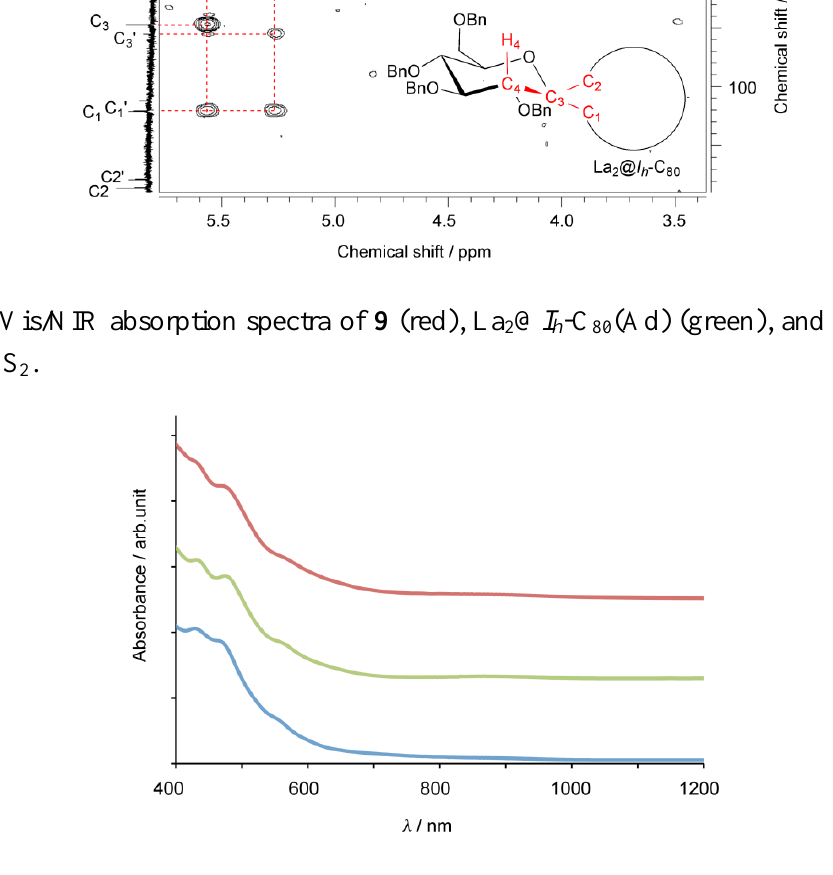
Figure 3. 500 MHz HMBC NMR spectrum of 9 in CD shows the schematic structure of 9 .